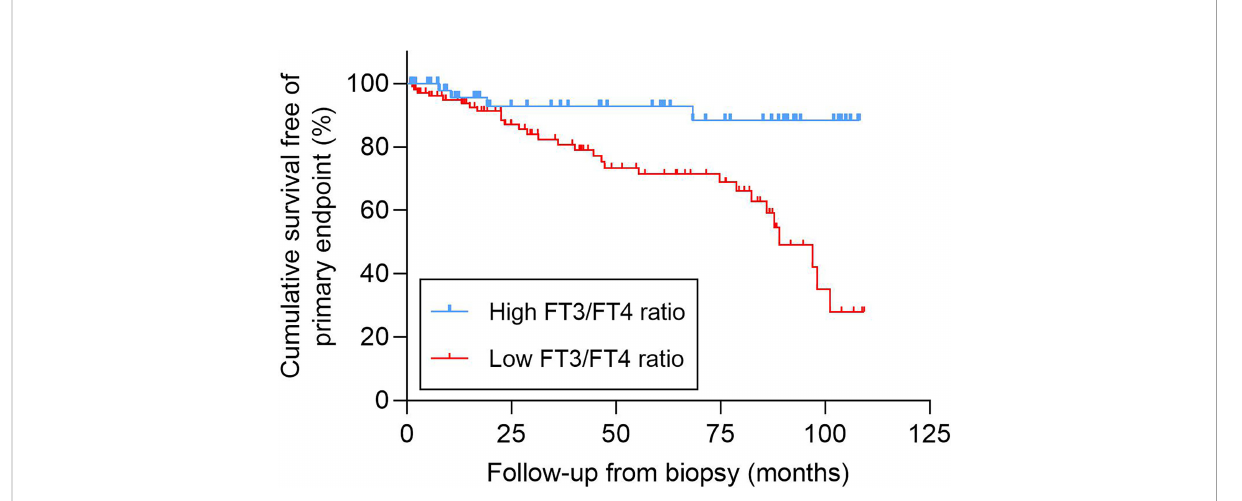
FIGURE 2 Kaplan-Meier analysis of the cumulative event-free survival according to the FT3/FT4 ratio. FT3, free triiodothyronine; FT4, free